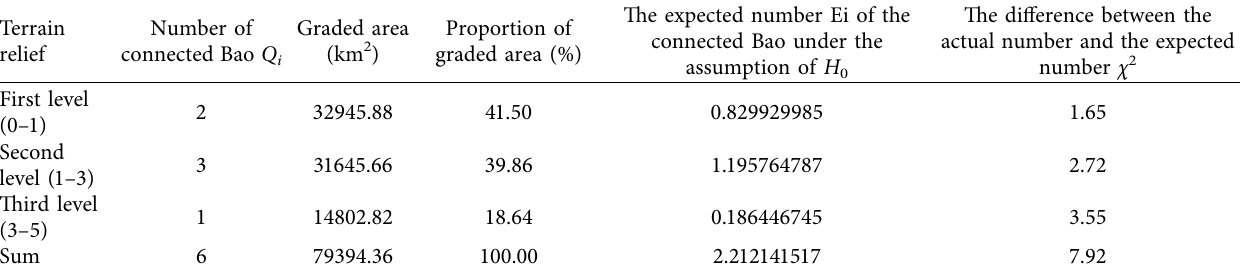
Table 4: Univariate chi-square test for the terrain relief.